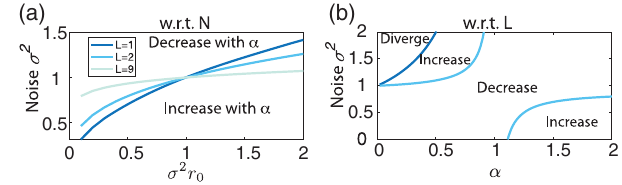
FIG. 5. Summary plot showing different parameter regimes for the dependence of the generalization error on width ( N ) and depth ( L ). (a) Plane of noise σ 2 and σ 2 r 0 (the input readout parameter r 0 is normalized by σ 2 so that σ 2 r 0 is independent of σ ). Above the boundary lines, the generalization error decreases with α ; below it, the generalization error increases with α . The three different curves are for L ¼ 1 , L ¼ 2 , and L ¼ 9 . The separating line becomes flatter as L increases. (b) For a fixed σ 2 r 0 , in the plane of α and σ 2 , there are three types of behaviors of ε vs L : It can g decrease, increase, or diverge. Note that in the narrow regime ( α > 1 ), ε never diverges, consistent with Eq. g